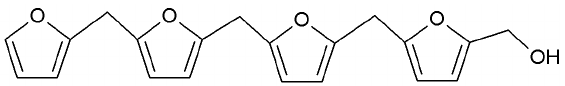
9 of 14 Figure 7. FTIR spectra of furanic-glyoxal foams without olive stone flour added.